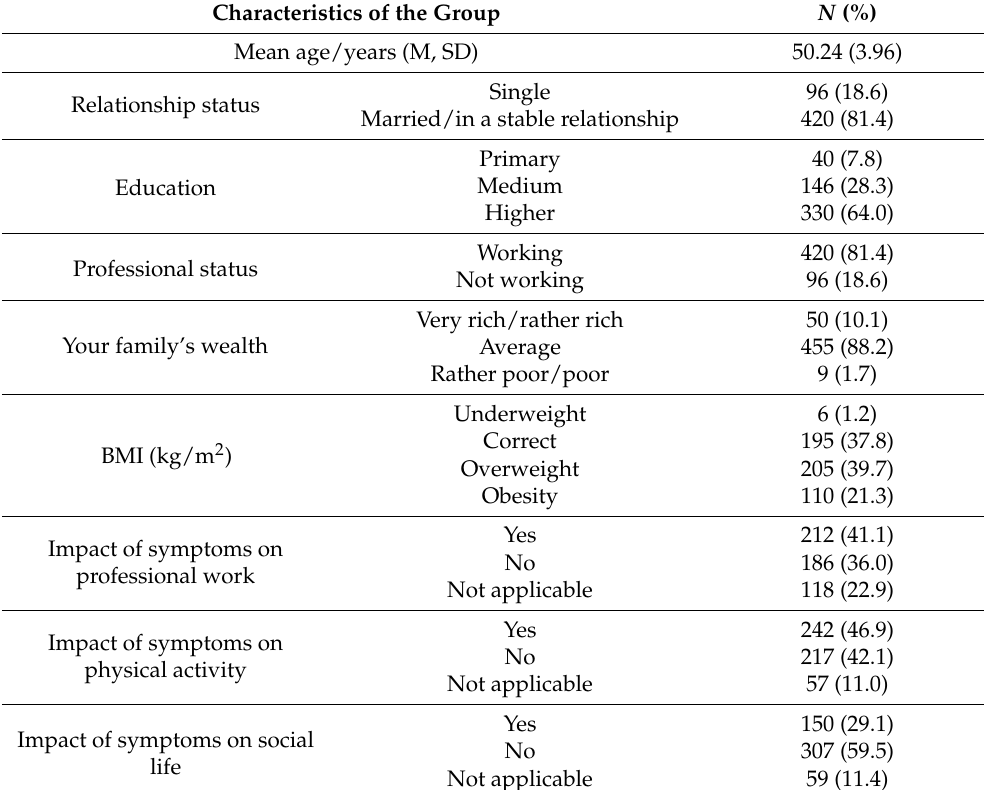
Table 1. Sociodemographic characteristics of the